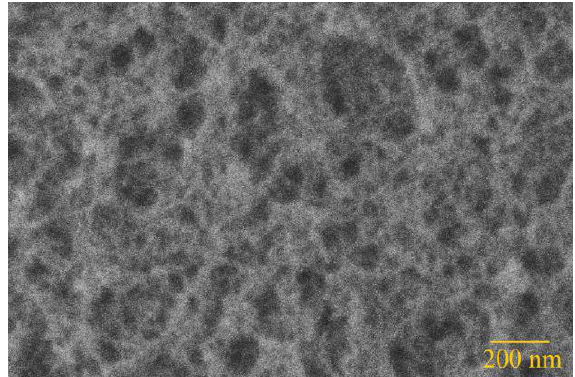
Figure 4. Pore structure of the silica aerogel shown in a SEM picture. The pores have a diameter of 20–80